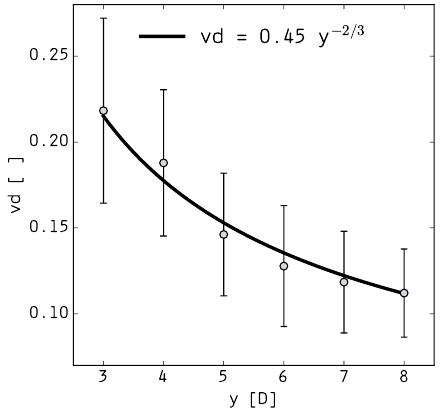
Figure 11. Temporal mean (markers) and standard deviation (whiskers) of the spatially-averaged velocity deficit ( vd ) estimated from field measurements. Considering 59 3D scans in the 22-h period. Similarity prediction given by the solid black